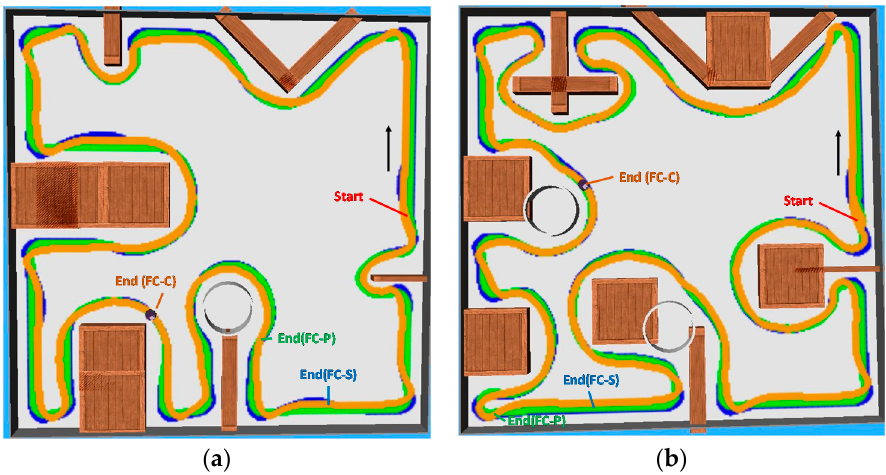
Figure 9. The trajectories of the robot in ( a ) the training environment and ( b ) an unknown test environment using the fuzzy controllers with the best position performance (FC-P), the best speed (FC-S), and a constant speed (FC-C).